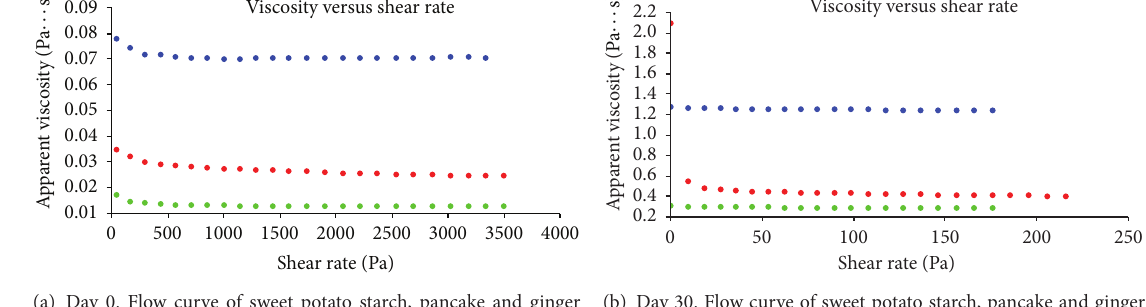
(a) Day 0. Flow curve of sweet potato starch, pancake and ginger syrups